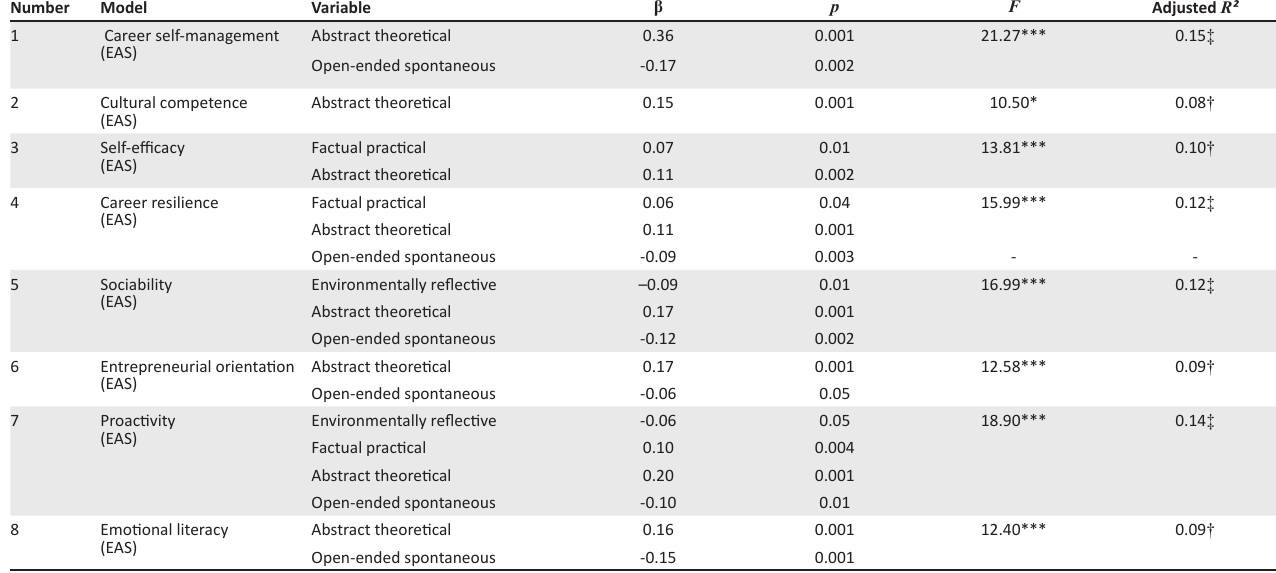
TABLE 3: Significant multiple regression analysis: EPI (independent variables) versus EAS (dependent variables).